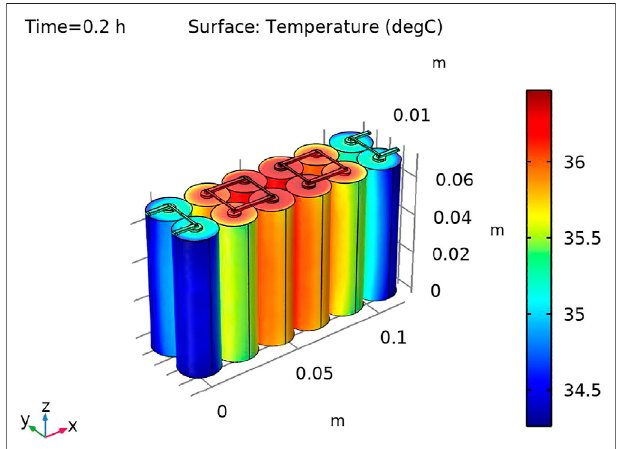
FIGURE 12 | Temperature distribution in the battery